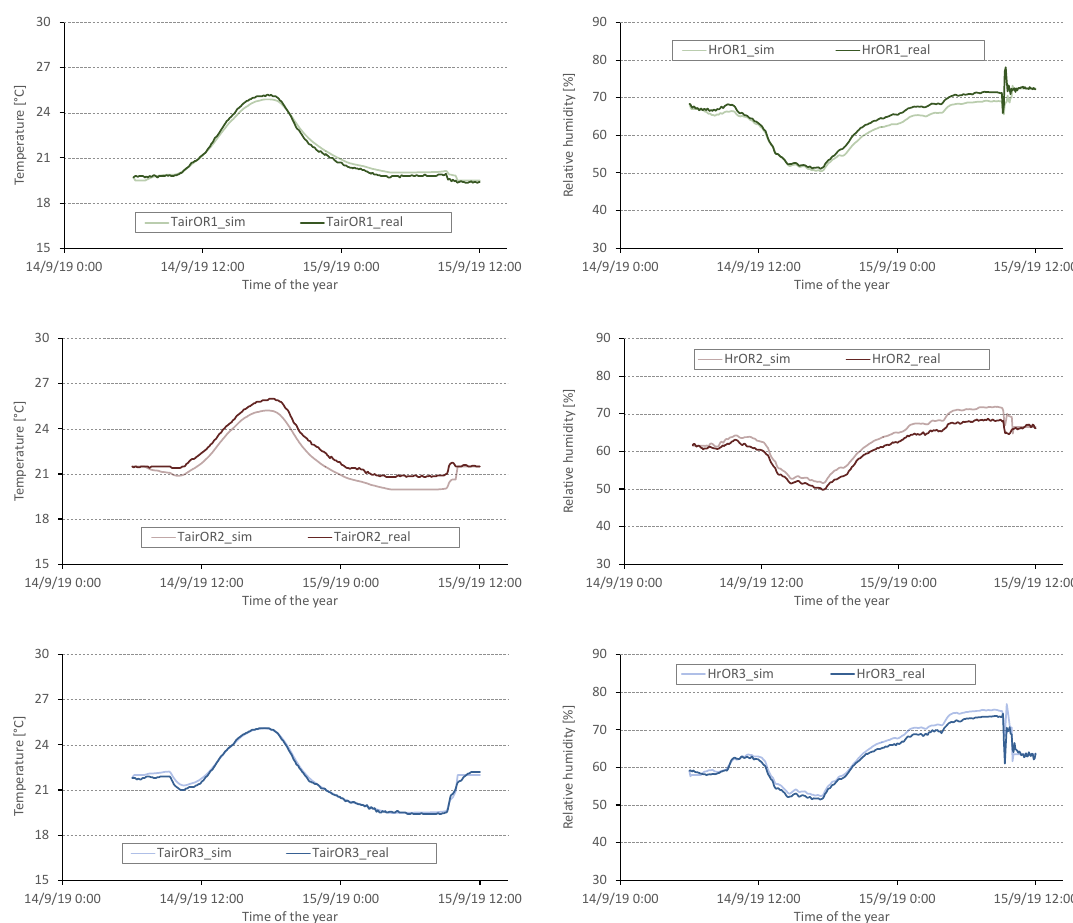
Figure 10. Comparison between simulated and experimental air temperature and RH in the ORs during the second data campaign.